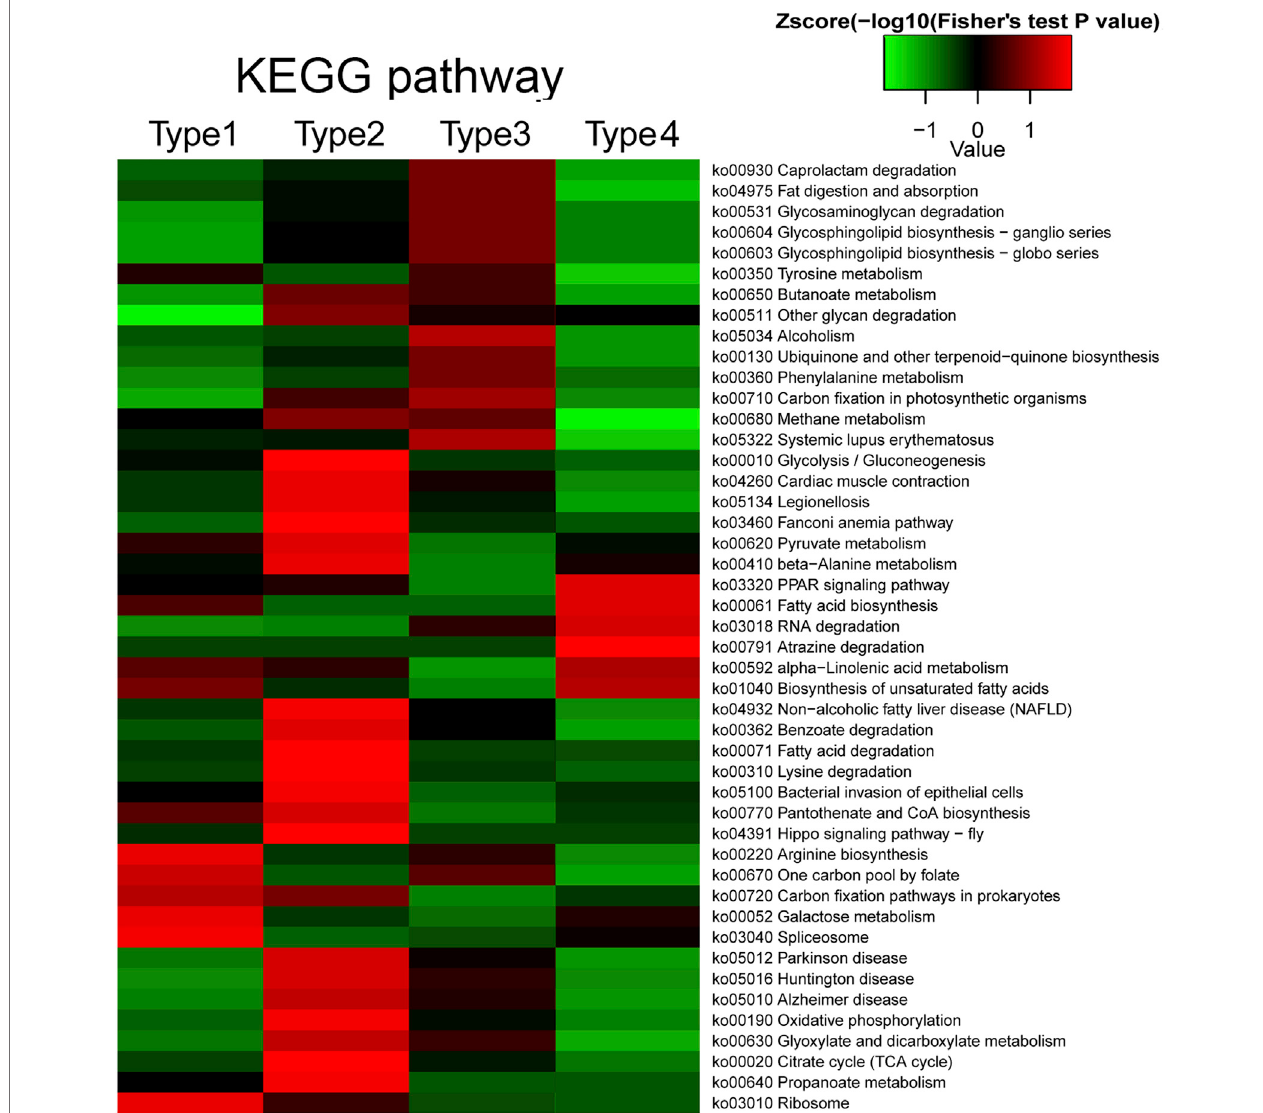
FIGURE 8 | Crosstalk of crotonylation with acetylation, succinylation, and propionylation based on KEGG enrichment. Type 1 represents proteins commonly modi fi ed by crotonylation and acetylation; type 2 represents proteins commonly modi fi ed by crotonylation and succinylation; type 3 represents proteins commonly modi fi ed by crotonylation and propionylation; and type 4 represents proteins speci fi cally modi fi ed by crotonylation.